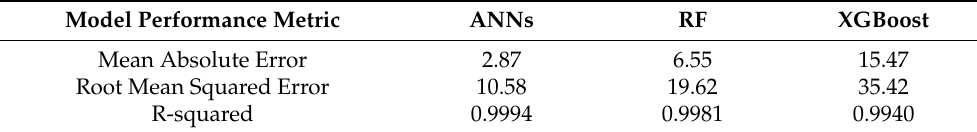
Table 6. Model performance on test